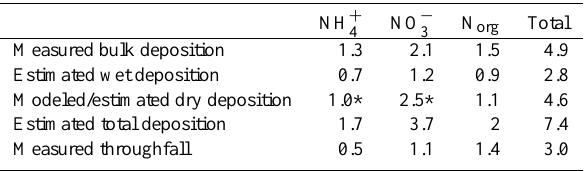
Table 4. The measured atmospheric annual bulk N deposition, esti- mated annual wet N deposition and modeled annual dry N deposi- tion, all in kgNha − 1 yr − 1 )